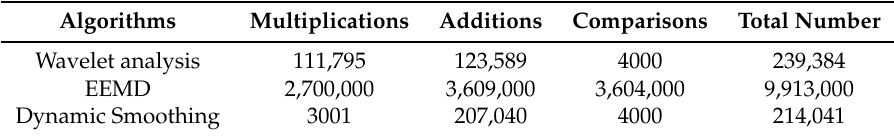
Table 7. Quantitative comparisons of time complexity with N